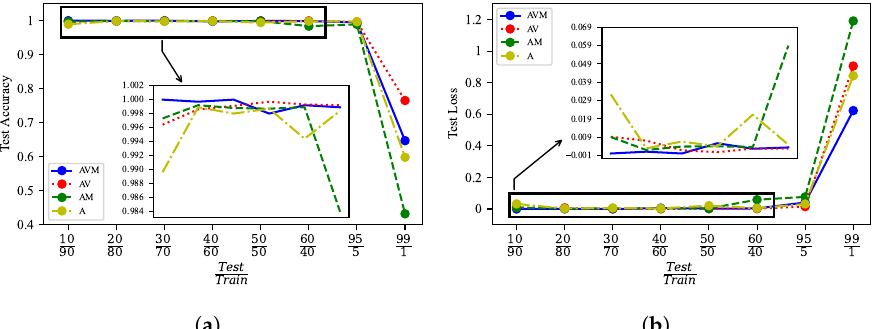
Figure 11. The distribution of green hen data in different test-to-train ratios.